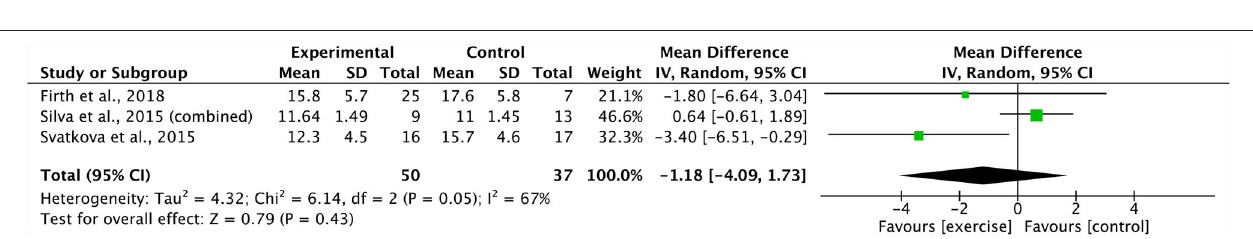
FIGURE 6 | The effects of combined aerobic and resistance training on body mass index scores.